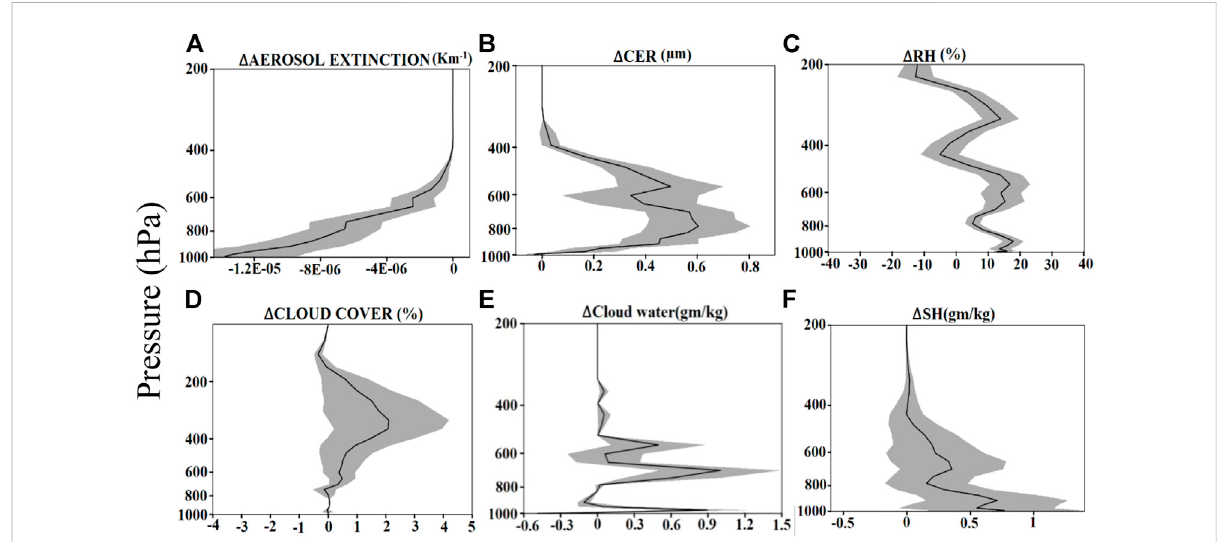
FIGURE 3 Area averaged (78:90 ° E, 18 – 27 ° N) ECHAM6-HAMMOZ simulated anomalies (C19 — CTRL) averaged over 10 members and for the lockdown period for (A) Aerosol extinction coef fi cient (km − 1 ), (B) cloud effective radius ( Δ CER, µm), (C) relative humidity ( Δ RH, %), and (D) cloud cover (%), (E)